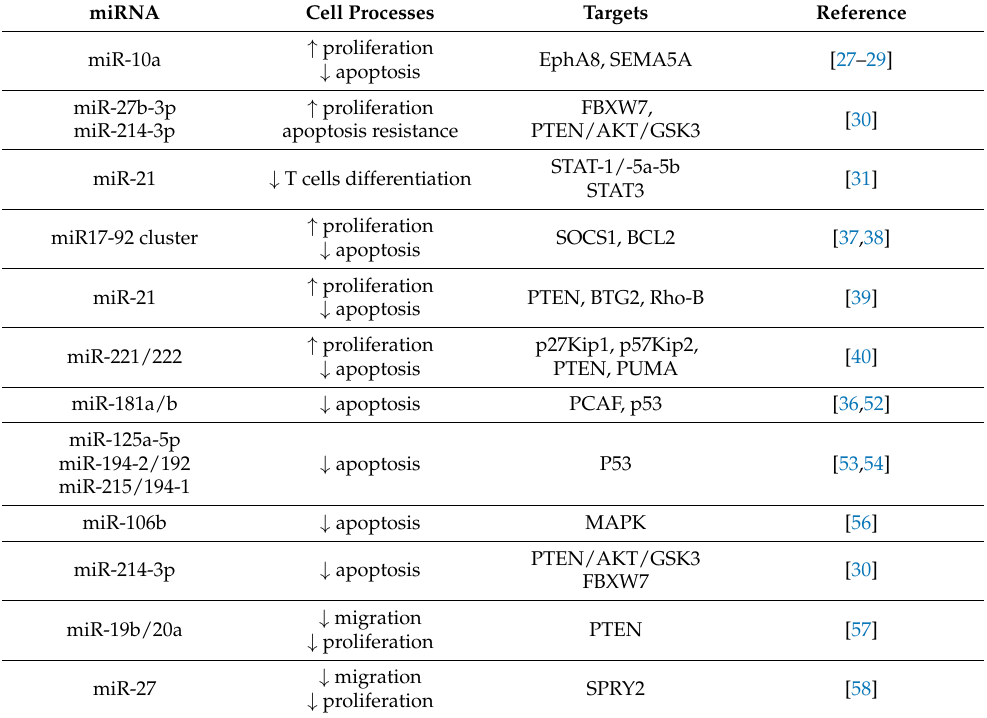
Table 1. List of selected oncomirs in MM. ↑ —increased expression, ↓ —decreased expression.